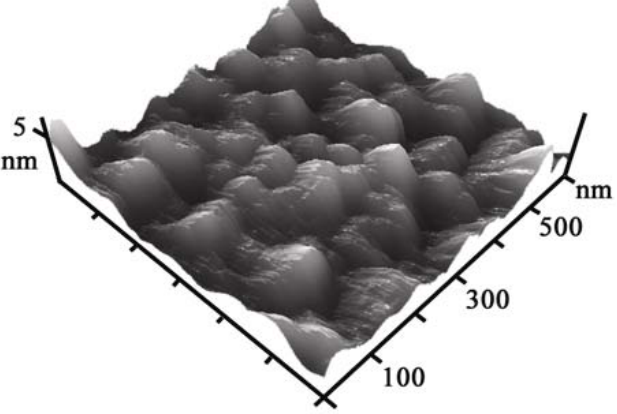
Figure 1. AFM image of Au nanoparticle surface formed by sputtering. The diameters of